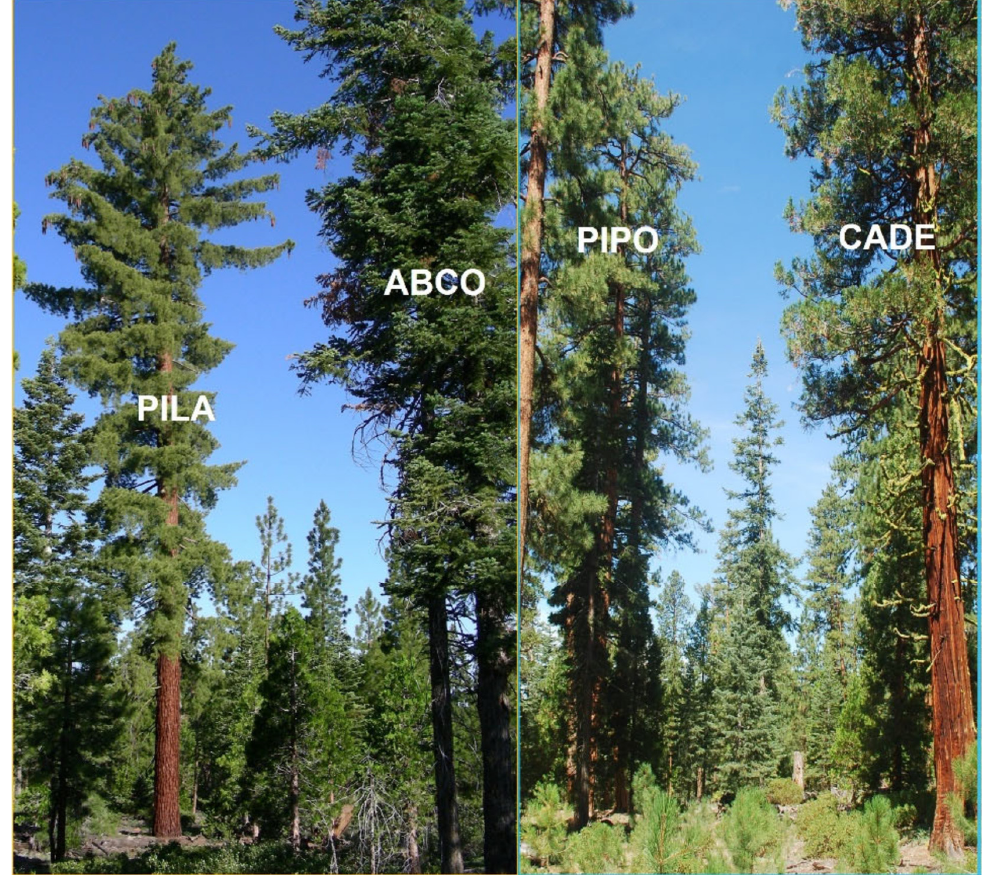
Figure 2. The most common tree species encountered in the study were white fir ( Abies concolor — ABCO), followed by sugar pine ( Pinus lambertiana —PILA), ponderosa pine ( Pinus ponderosa —PIPO), and incense cedar ( Calocedrus decurrens